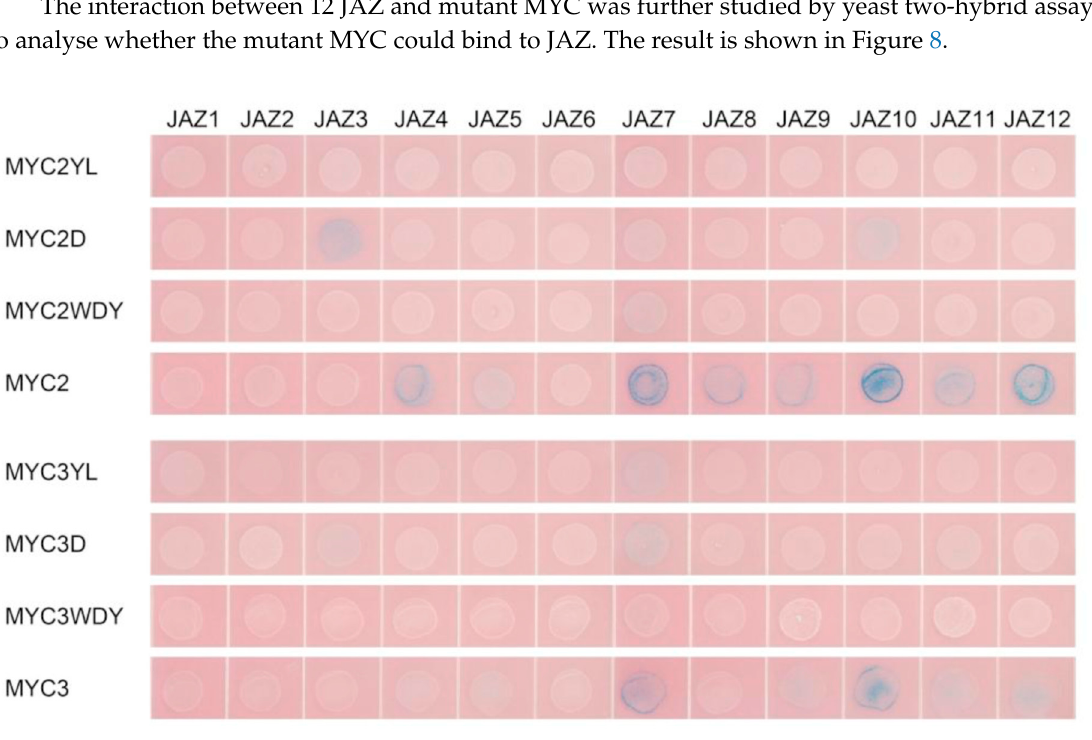
Figure 8. Results of the interaction between the MYC-type transcription factor and JAZ in a yeast two-hybrid assay.